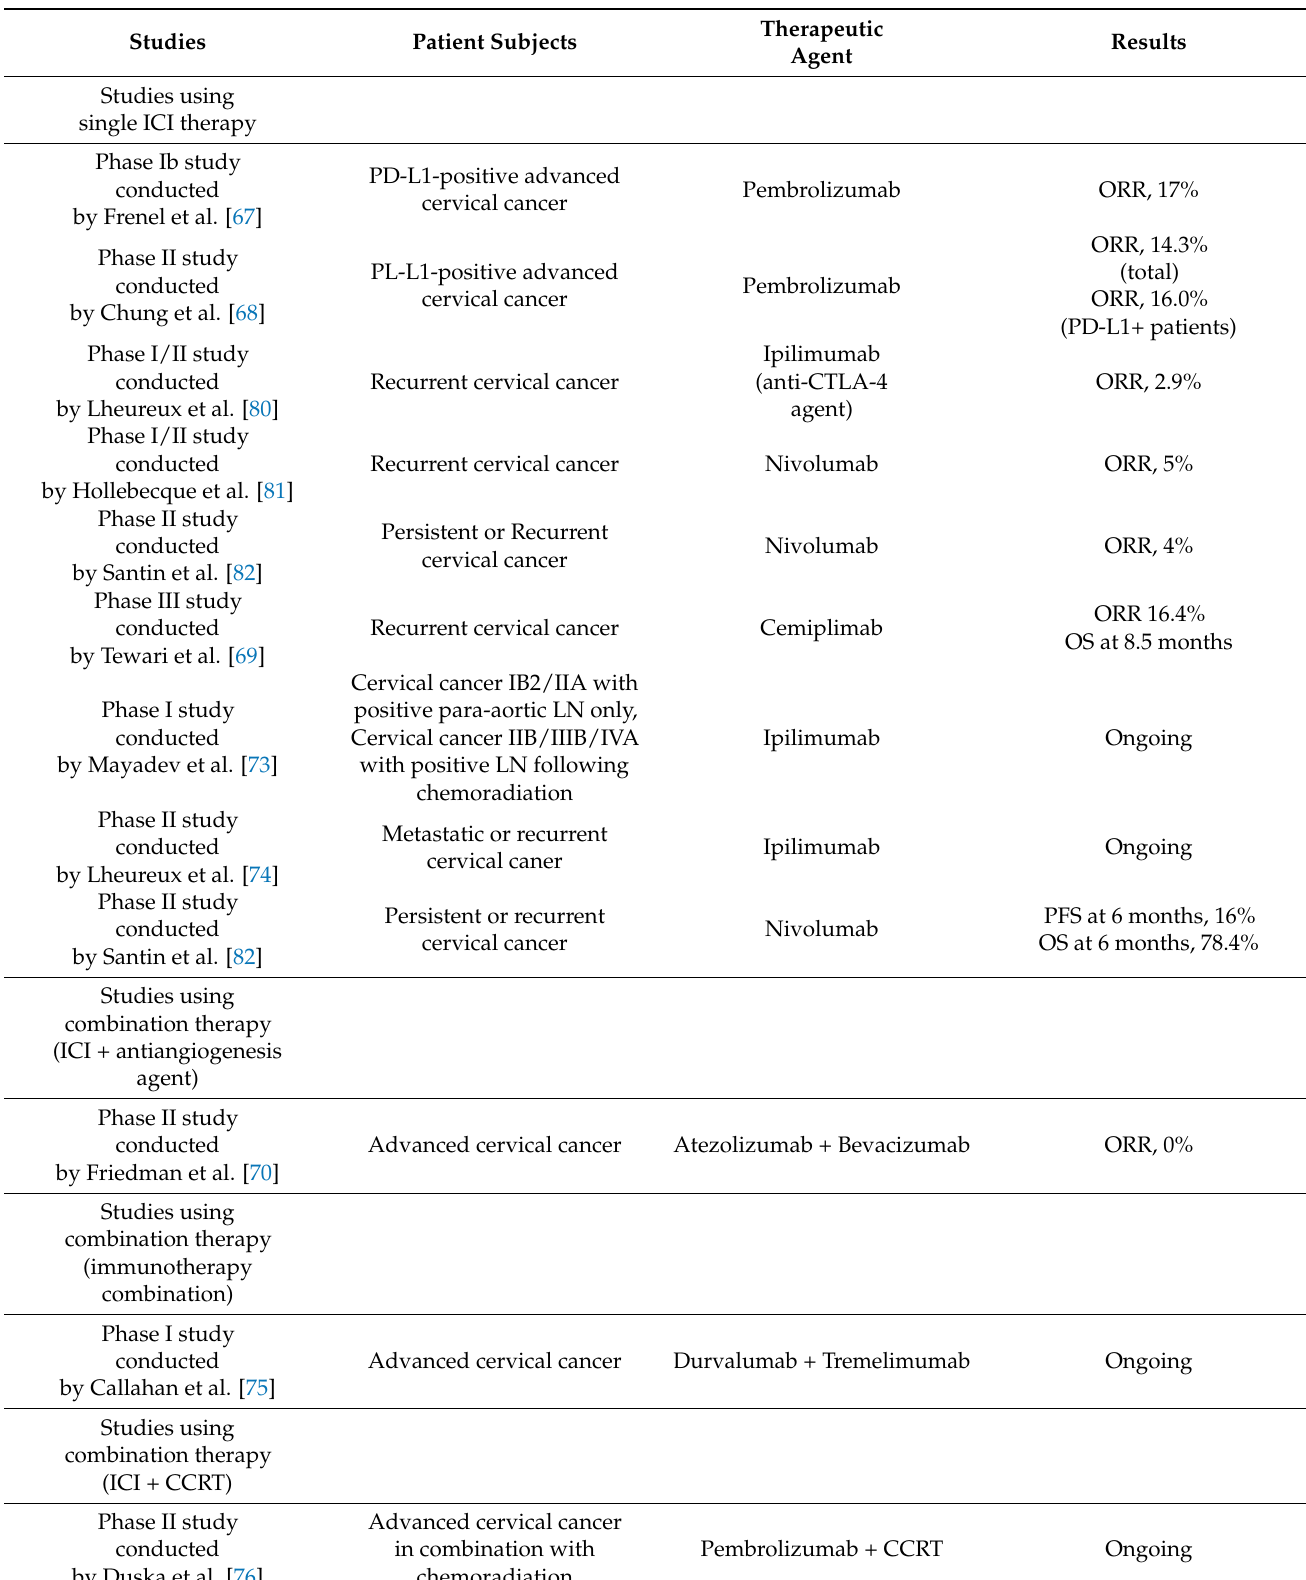
Table 3. ICI monotherapy and combination therapy, including ICI used in cervical